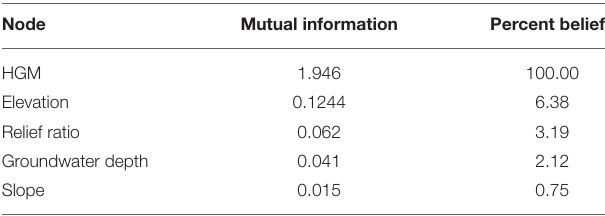
TABLE 4 | Node sensitivity of variable nodes relative to the “HGM” node.